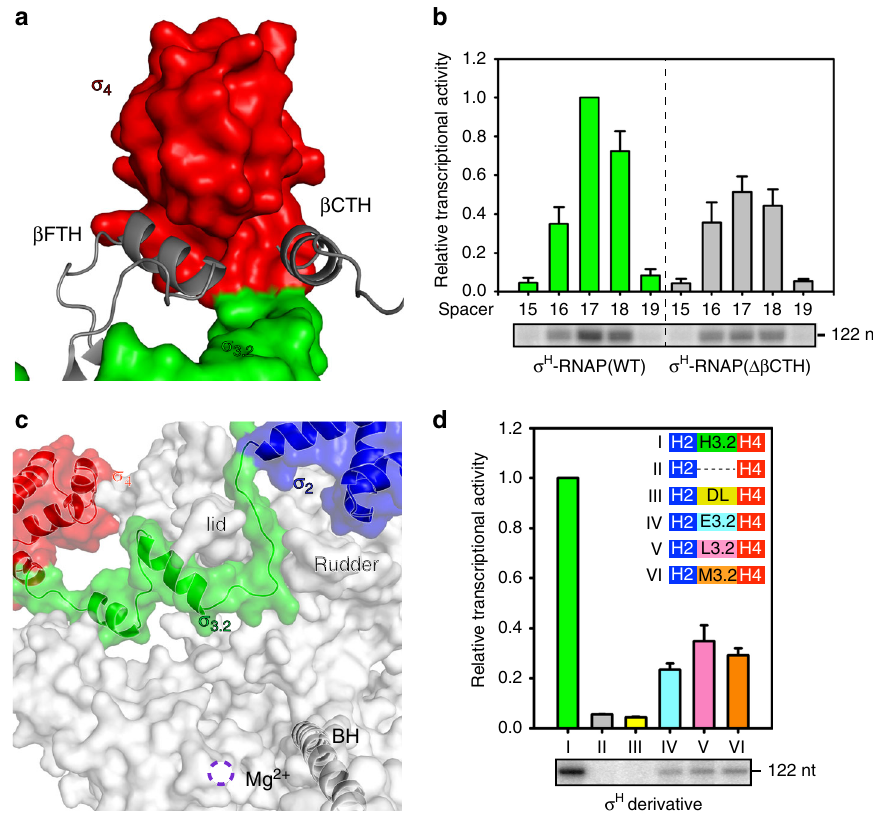
Fig. 2 The interaction between Mtb RNAP core enzyme and σ H . a Both β FTH and β CTH interact with σ H 4 . Colors are as in previous fi gure. b The in vitro transcription activity of σ H -RNAP(WT) (green bars) and σ H -RNAP( Δ β CTH) (gray bars) from pClpB promoter variants with − 35/ − 10 spacer length of 15 – 19 base pairs. “ 122 nt ” indicates length of run-off RNA products. c The interaction between σ H 2 / σ H 4 linker ( σ H 3.2 ) and RNAP core enzyme. RNAP- β subunit was omitted for clarity. The location of catalytic Mg 2 + is shown by a dashed purple circle. BH, bridge helix. RNAP- β ′ subunit, gray. σ H 2 , σ H 3.2 , and σ H pClpB promoter of RNAP holoenzymes comprising σ H derivatives. H2-H3.2- 4 , blue, green, and red respectively. d The in vitro transcription activity from H4, wild-type σ H ; H2---H4, two individual domains of σ H 2 and σ H 4 ; H2-DL-H4, a chimeric σ H with σ H 3.2 replaced by a disordered loop with an equivalent residue number; H2-E3.2-H4, a chimeric σ H with σ H 3.2 replaced by Mtb σ E 3.2 ; H2-L3.2-H4, a chimeric σ H with σ H 3.2 replaced by Mtb σ L 3.2 ; H2-M3.2-H4, a chimeric σ H with σ H 3.2 replaced by Mtb σ M 3.2 . The experiments were repeated in triplicate, and the data are presented as mean ± S.E.M. Source data of b and c are provided as a Source Data fi